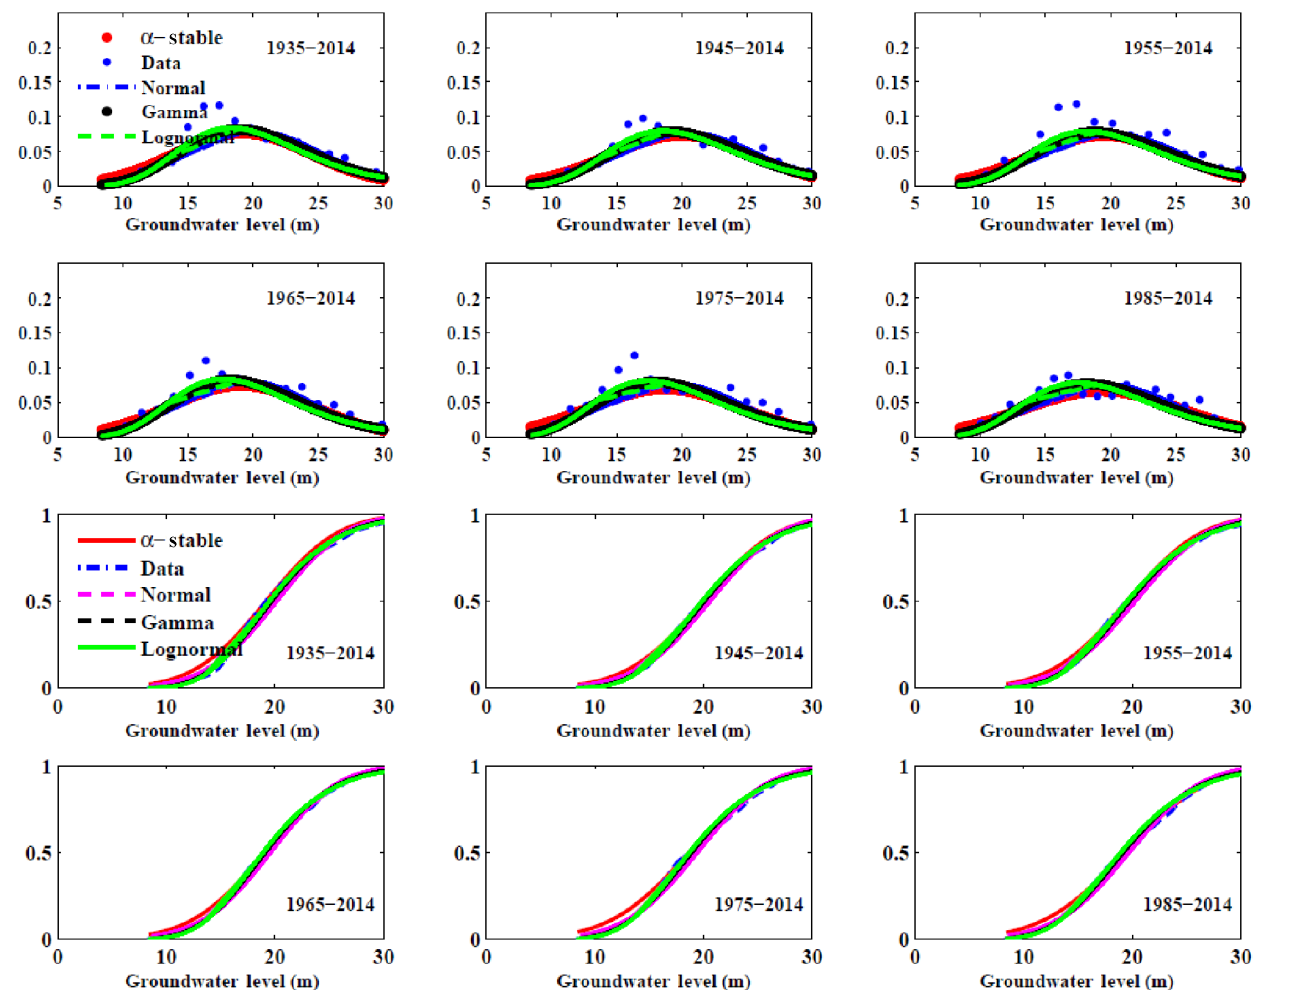
Figure 13. Probability density function and cumulative distribution function (first two rows and last two rows, respectively) of groundwater level fluctuation time series data of Well